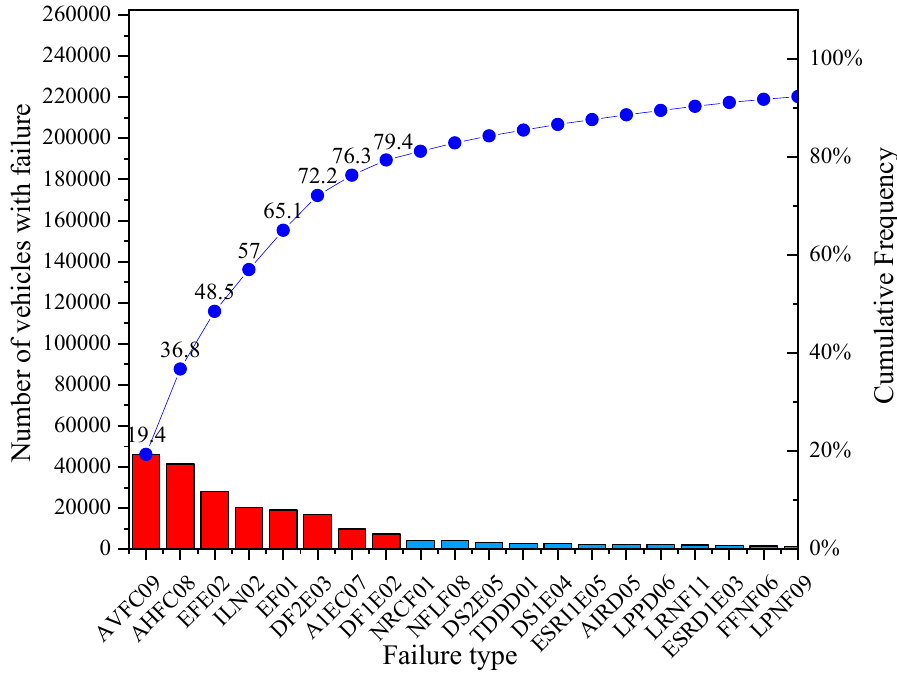
Figure 5. Representative failures in VTI for subcategory M1.